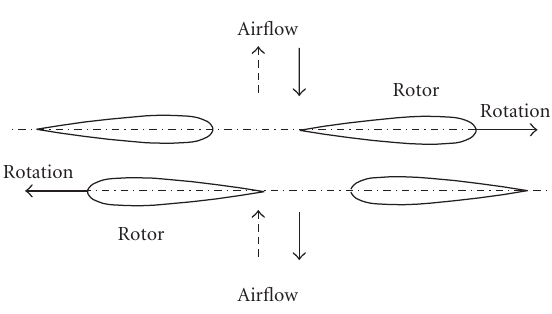
Figure 6: Biplane Wells turbine with guide vanes (BWGV).